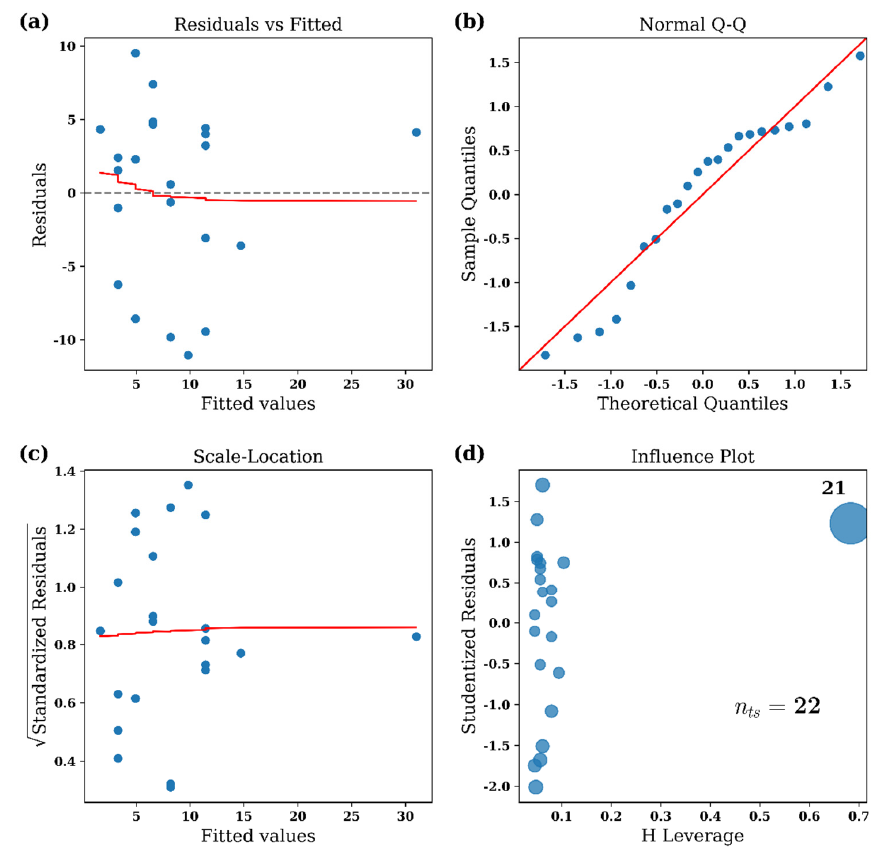
Figure 7. Diagnosis of linear fitting in Figure 6: ( a ) the residuals (the vertical distance from a point to the fitted line) vs. fitted values (y-value on the line corresponding to each x-value); ( b ) normal Q-Q plot of the residuals; if residuals are normally distributed, data points will lie close to the 45° line (red line); ( c ) square root of the standardized residuals vs. fitted values; ( d ) studentized residuals vs. leverage; the point size reflects the Cook’s distance which measures how much each data point influences the regression and increases with leverage and large residuals; the numbered points (the digit is the sequence number starting from 0 in the test set; the larger the MHD is, the bigger the digit is) are those that have a significant influence on the fit. The red lines in ( a ) and ( c ) are smoothed curves that pass through the actual residuals.